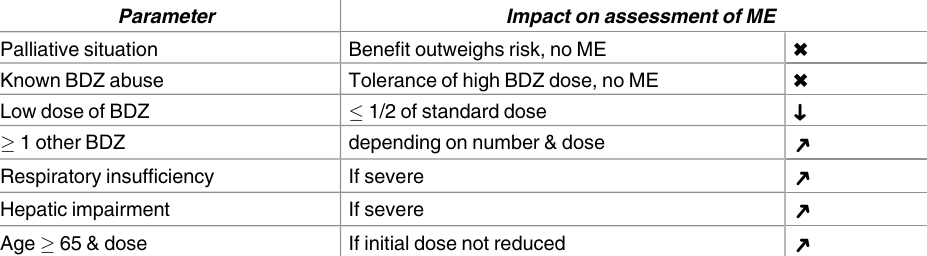
Table 1. Qualitative impact of patient parameters on validation of